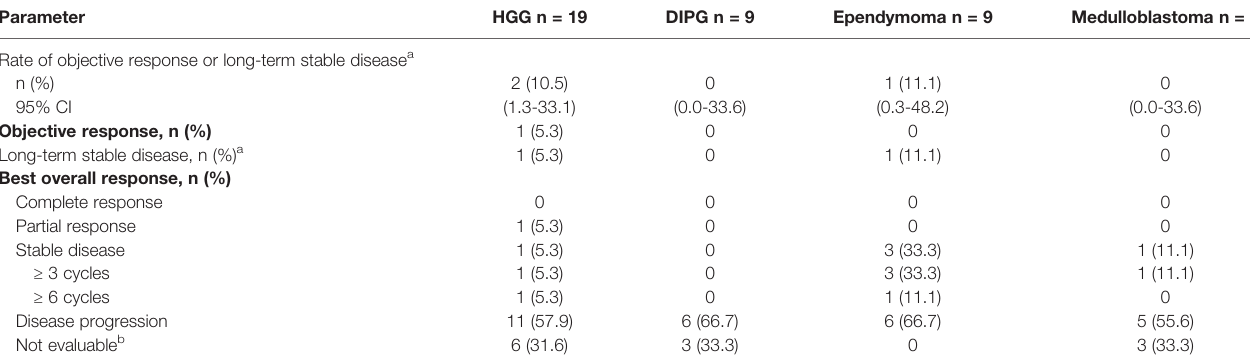
TABLE 2 | Objective Response and Long-Term Stable Disease per Independent Central Review (response population).